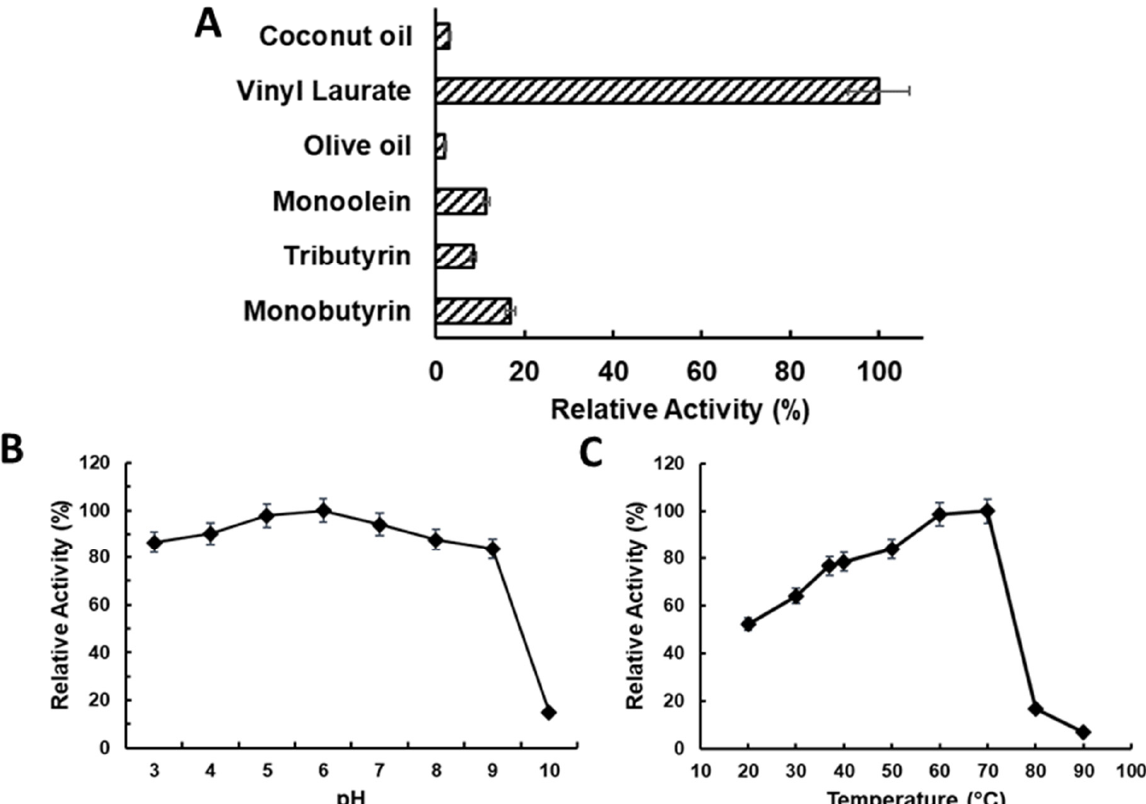
Figure 3. Relative activity of LTL1 hydrolysis assays for ( A ) substrate; ( B ) pH, and ( C ) temperature specificity. LTL1 displayed the highest hydrolysis preference for vinyl laurate among other substrates (coconut oil, olive oil, monoolein, tributyrin, and monobutyrin), while maintaining stable hydrolysis of tributyrin between from pH 3.0 to 9.0, and was thermostable up to 70 °C.